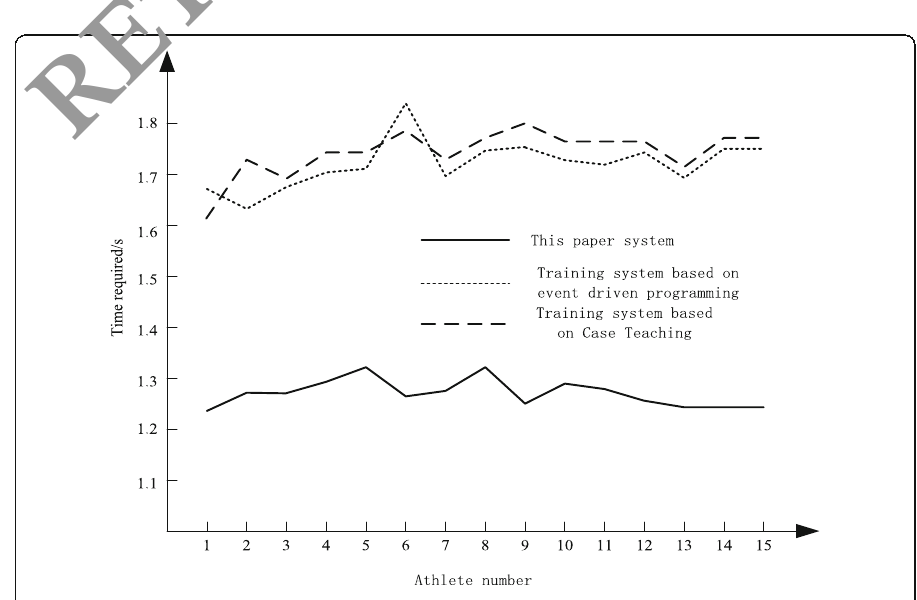
Fig. 7 Time consuming for movement simulation of three